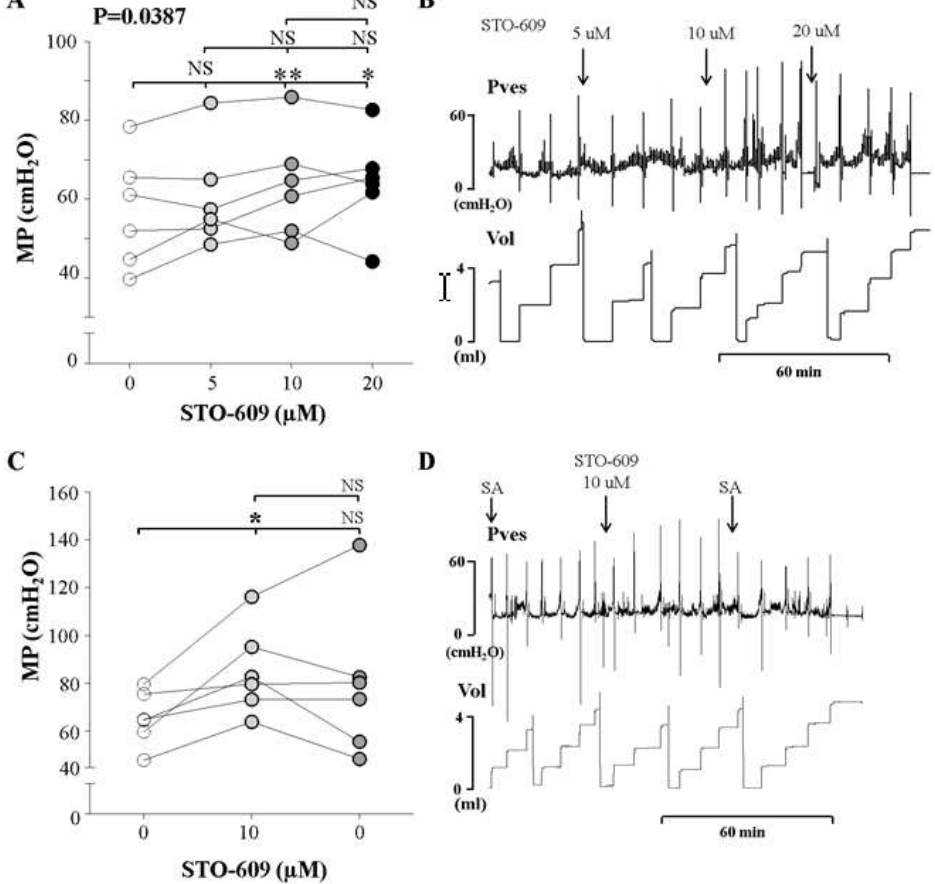
Figure 4. E ff ects and representative tracings of intravesical selective inhibitors of CaMKK β (STO-609, A , B ) with three consecutive increasing concentrations on the micturition pressure (MP) on cystometry, in order to identify the smallest dose showing a valid e ff ect. NS: not significant, * p < 0.05 and ** p < 0.01 compared to the control or the other dose; repeated one-way analysis of variance with the Dunnett post hoc test ( A ). STO-609 increased the MP starting at an injected concentration of 10 µ M, compared to the control group ( C , D ). The inhibitor was injected into the bladder, followed by normal saline. We did not use analysis of variance here, because this sub-experiment was conducted to compare the e ff ects of injecting inhibitor and saline. Thus, we used the t -test for statistical comparisons between each event. NS: not significant, SA: saline. *: p < 0.05, compared to control ( C